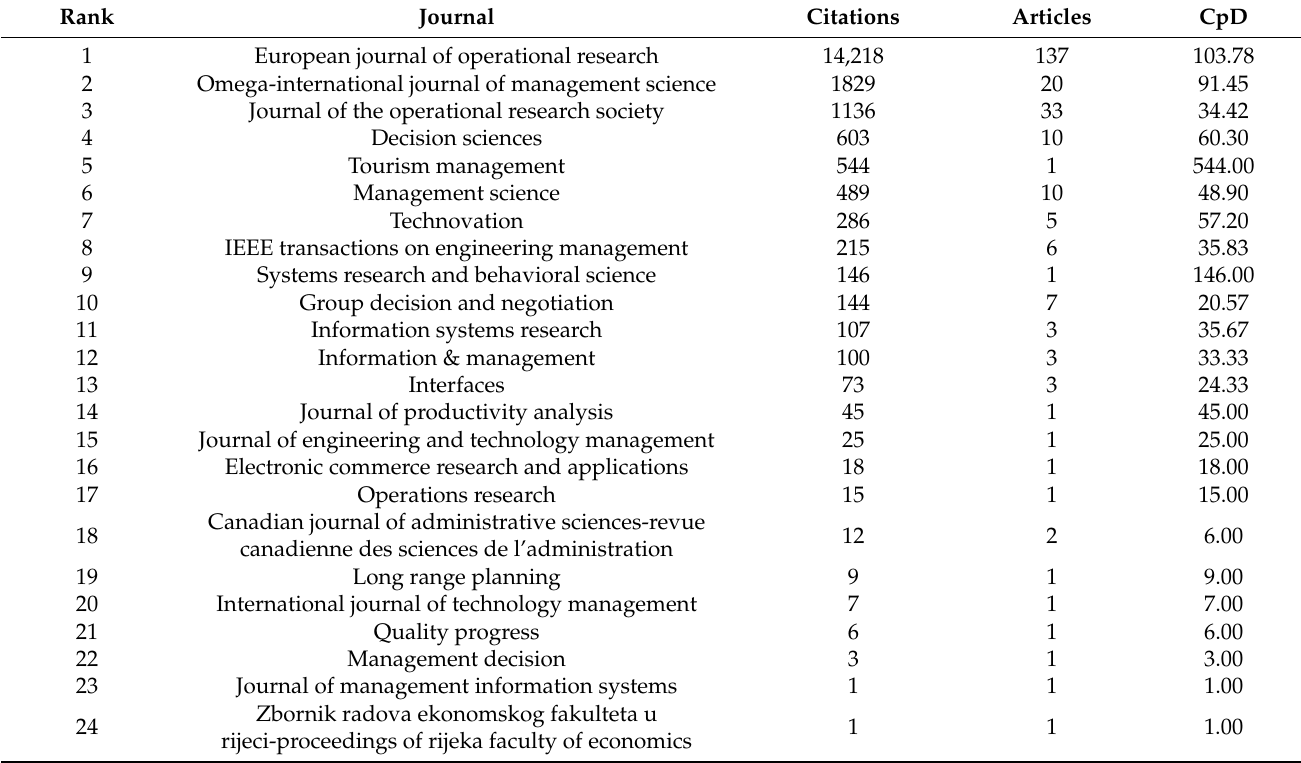
Table A5. Top journals in period 1 (1979–2008) for citations.